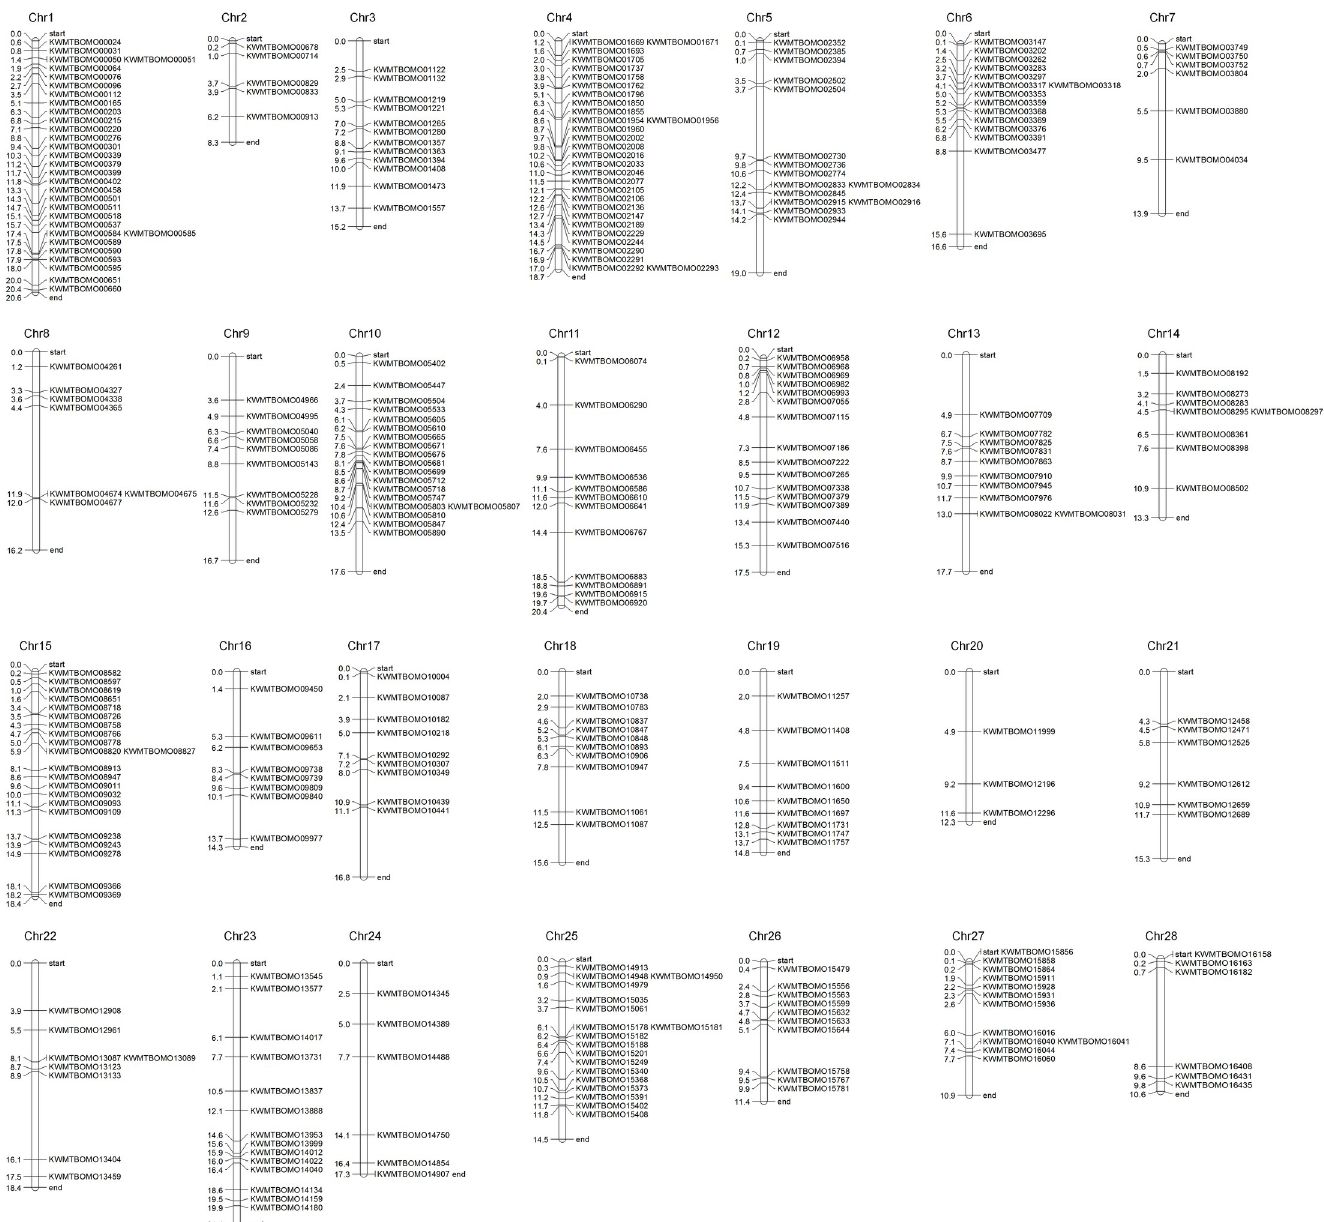
Fig 2. Chromosomal distribution of TFs identified in SG. The distribution map of TFs on 28 chromosomes of B . mori was constructed using online MapChart 2.32. The abbreviation Chr represents a chromosome. The distance unit on chromosomes is mega bases.